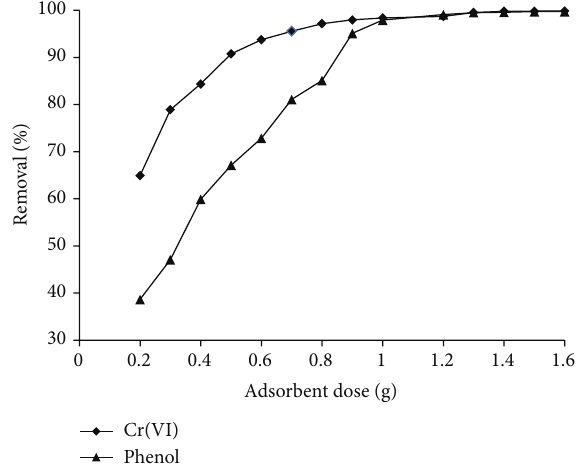
Figure 4: Effect of varying pH on adsorption of Cr(VI) and Phenol.